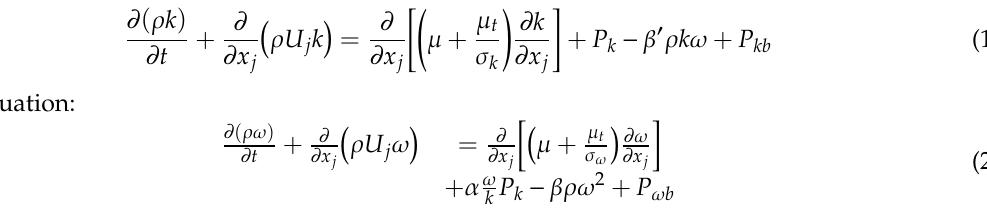
Figure 3. Grid diagram and the centrifugal pump with vanes.